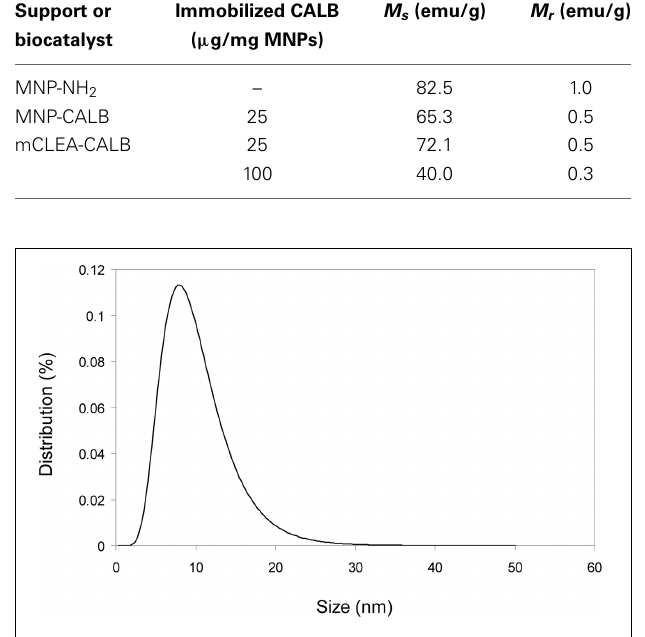
FIGURE 4 | Particle size distribution of MNPs. The distribution was fitted to the Langevin’s function yielding a mean particle size of 9.5nm and dispersion of ± 6nm.